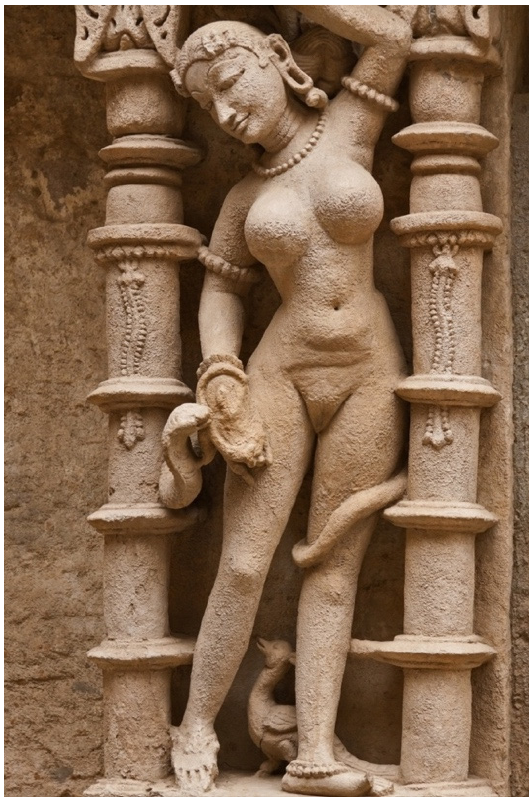
Figure 7. Serpent queen with a peacock gazing steadily at the snake at the pedestal (https://www.dreamstime.com/photos-images/patan-step-well.html, accessed on 20 July 2022). Table 2. Summary of evidence identified from major stepwell sites used for irrigation in central and northwest